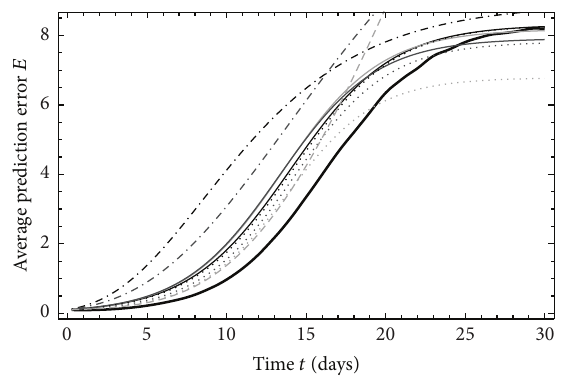
Figure 5: The error growth rate 𝑑𝐸/𝑑𝑡 versus 𝐸 for ND 1 , 𝑀 5 . The thick line represents data from EPS, the thin lines from (9), the dotdashed lines from (10), the dotted lines from (11), and dashed linesfromNS(7).Thelightgreylinesrepresentthedataextrapolated from time length 𝜏 1 , the grey lines represent the data extrapolated from time length 𝜏 2 , and black lines represent the data in time length 𝜏 3 .